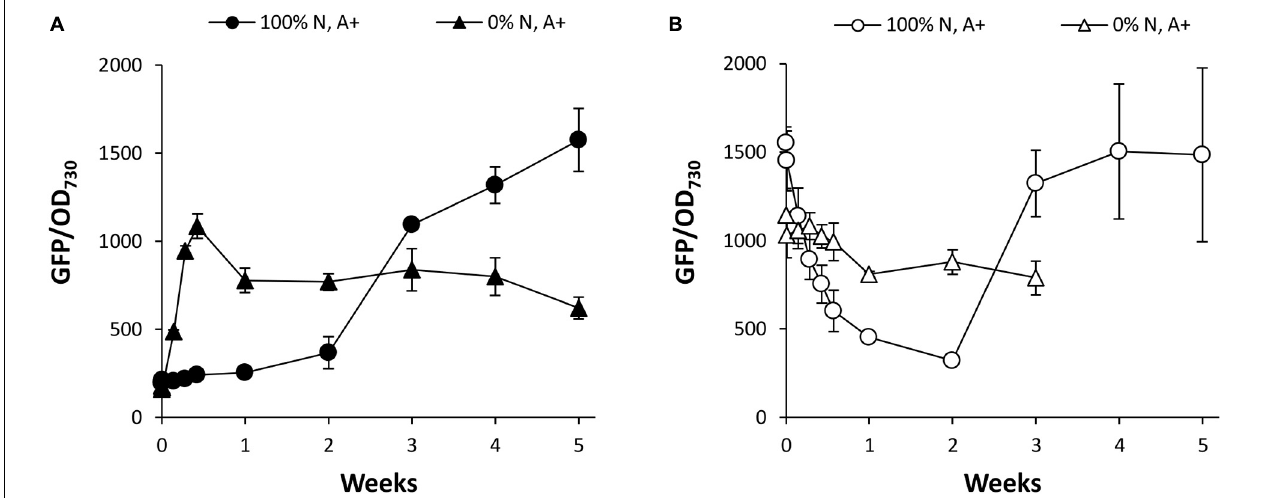
FIGURE 7 | The effect of N supply on PndbA600 activity. PndbA600 activity (GFP fluorescence normalised to OD 730 ) in Synechococcus PndbA600:GFP grown in media containing 0 or 100% N in A + background. Cultures shown in (A) were started from young, low density cultures with low promoter activity (OD < 5, GFP < 300, black symbols), and cultures shown in (B) were started from mature, high density cultures with high promoter activity (OD > 12, GFP > 850, white symbols). All cultures were resuspended to OD 1 in the indicated media at time point 0. Data are means ± S.E.M. of three independent cultures. Accompanying growth curves are presented in Supplementary Figure S6 .